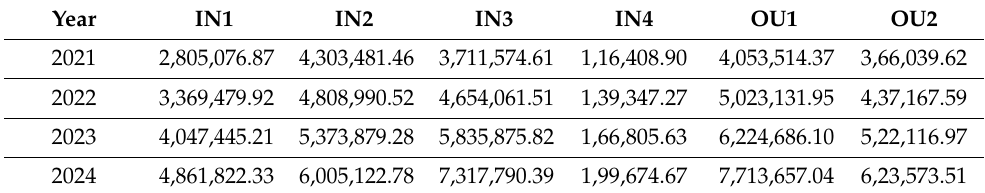
Table 13. Forecast results of LO7 (calculated by